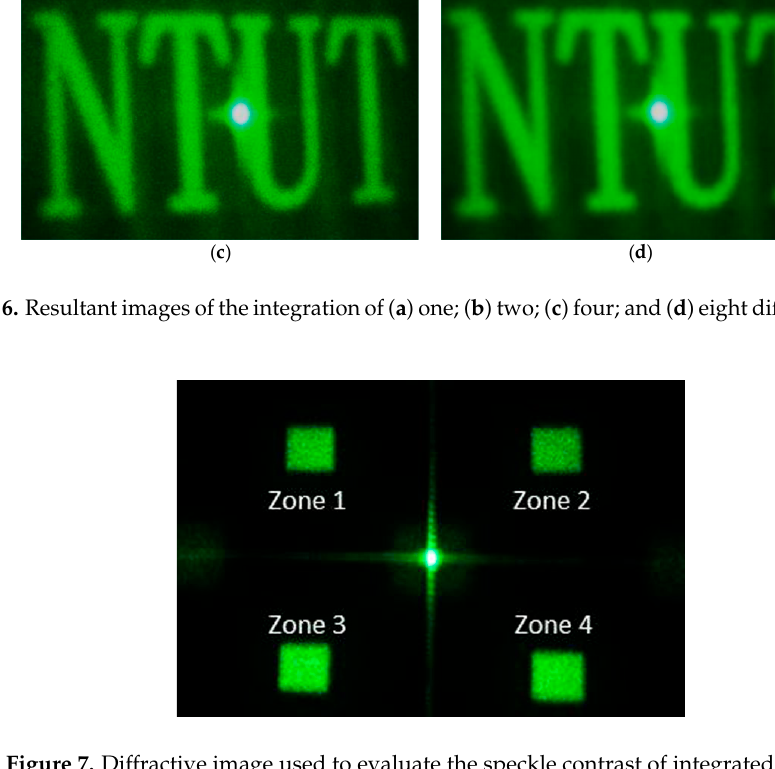
Figure 7. Diffractive image used to evaluate the speckle contrast of integrated images.